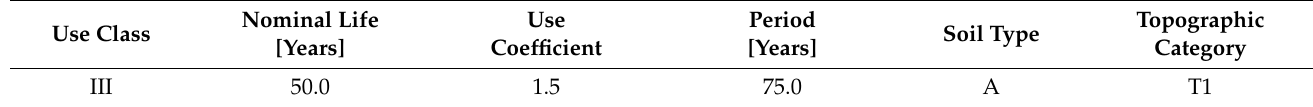
Figure 1. Location of the Town Hall of Palagianello (source Google Earth Pro). Table 1. Structure